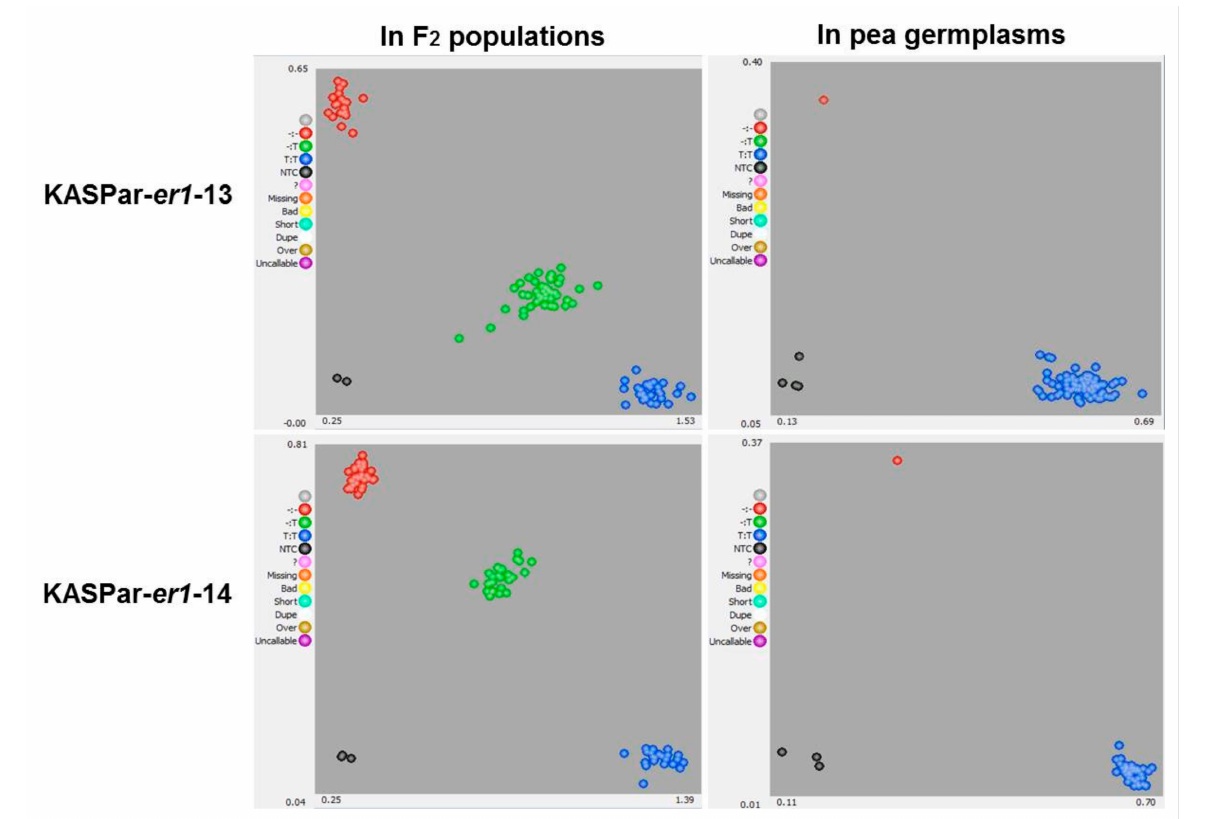
Figure 4. KASPar genotyping detection with markers KASPar-er1-13 and KASPar-er1-14 in the F 2 populations derived from Longwan 1 × Dabaiwandou and Chengwan 8 × Guiwan 1, as well as in other pea germplasms. Red dots indicate er1-13/er1-14 homozygous Erysiphe pisi - resistant lines/germplasms, blue dots indicate Er1-13/Er1-14 homozygous E. pisi -susceptible lines/germplasms, and green dots indicate er1-13/Er1-13 or er1-14/Er1-14 heterozygotes. Grey dots are blank samples used as controls. In our KASPar assay, the co-dominant markers KASPar- er1-13 and KASPar-er1-14 correctly categorized all F 2 individuals into three clusters corresponding to homozygous resistant (red dots), homozygous susceptible (blue dots), and heterozygous (green dots) lines, and categorized tested pea germplasms into two clusters corresponding to homozygous resistant (red dots) and homozygous susceptible (blue